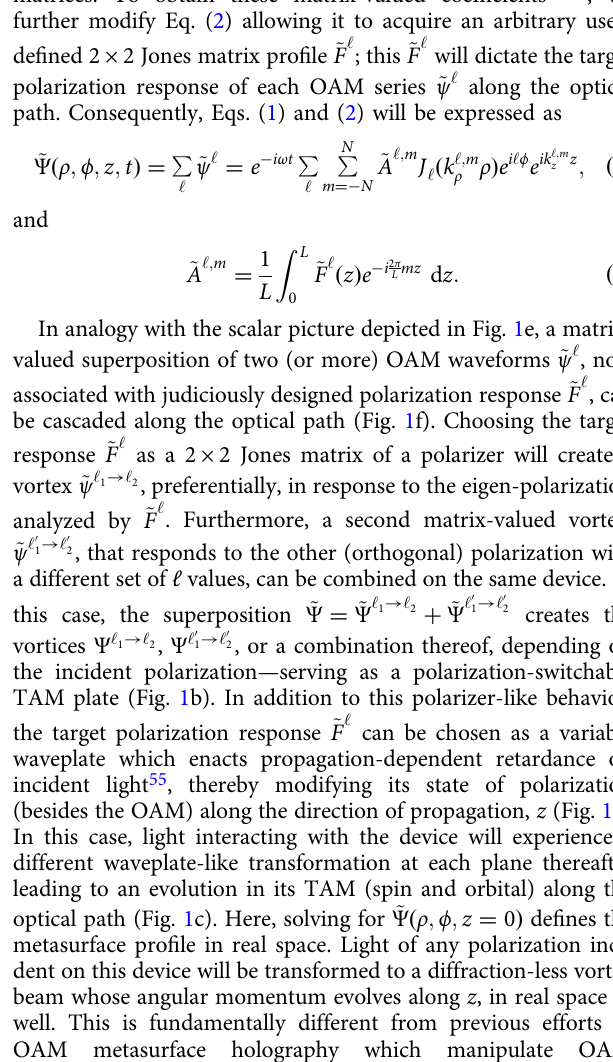
Fig. 1b. By changing the incident polarization, the device output can switch between two distinct propagation-dependent vortices (or a weighted average of the two). We refer to these two incident polarization states as the eigen polarizations of the device, λ þ and λ (cid:2) j i . The second, and more general, example of TAM plates is shown in Fig. 1c in which the device not only transforms incident light into a spatially varying vortex beam but also modi fi es its polarization state, at-will, at each plane thereafter — as if encountering polarizing elements with different retardance and/ or orientation ( ϕ z ). In the following, we begin by constructing a vortex beam with longitudinally varying charge (OAM), assuming a fi xed input polarization, by revisiting the scalar formulation presented in ref. 40 , then expand on it to realize our